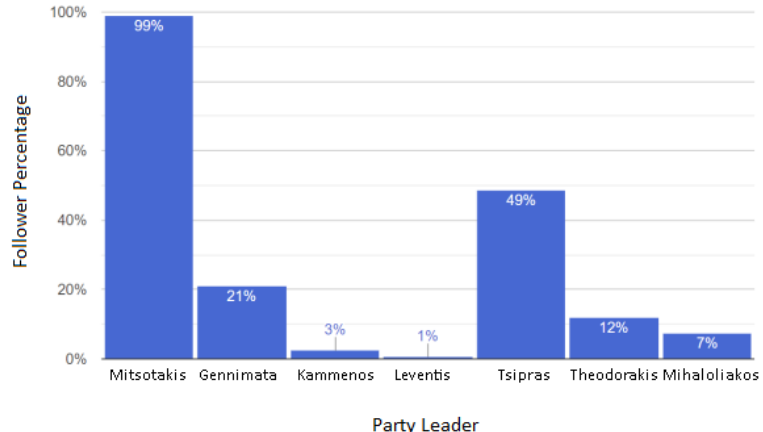
Figure 7. Follower increase percentage over the last 24